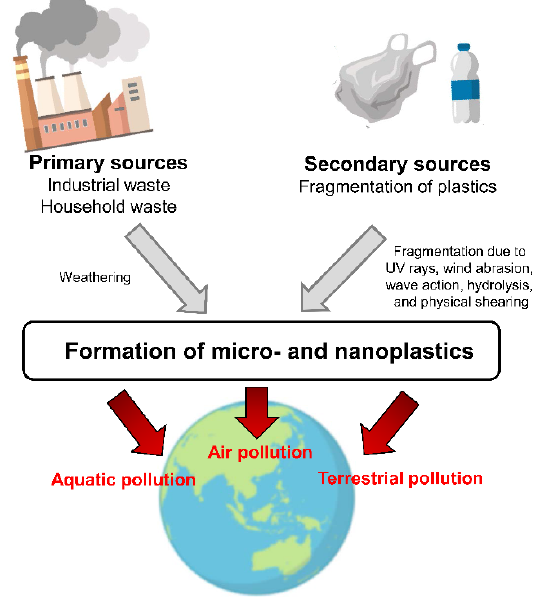
Figure 2. Sources of micro- and nanoplastics in the environment.